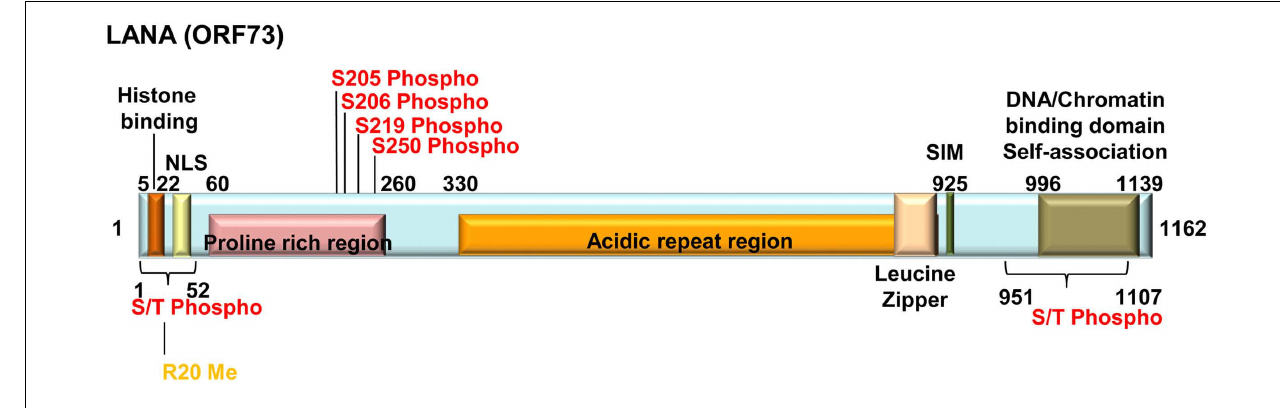
FIGURE 4 | Schematic representation of KSHV LANA. LANA protein and its post-translational modification sites as discussed in the text are depicted. Phosphorylation (Phospho) sites and the arginine methylation (Me) site are